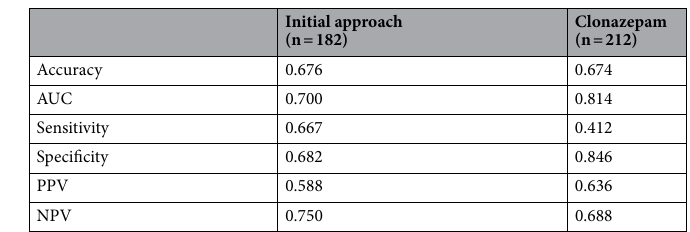
Table 1. Prediction performance of the two models for the initial approach and clonazepam therapy. AUC, area under receiver operating characteristic curve; PPV, positive predictive value; NPV, negative predictive